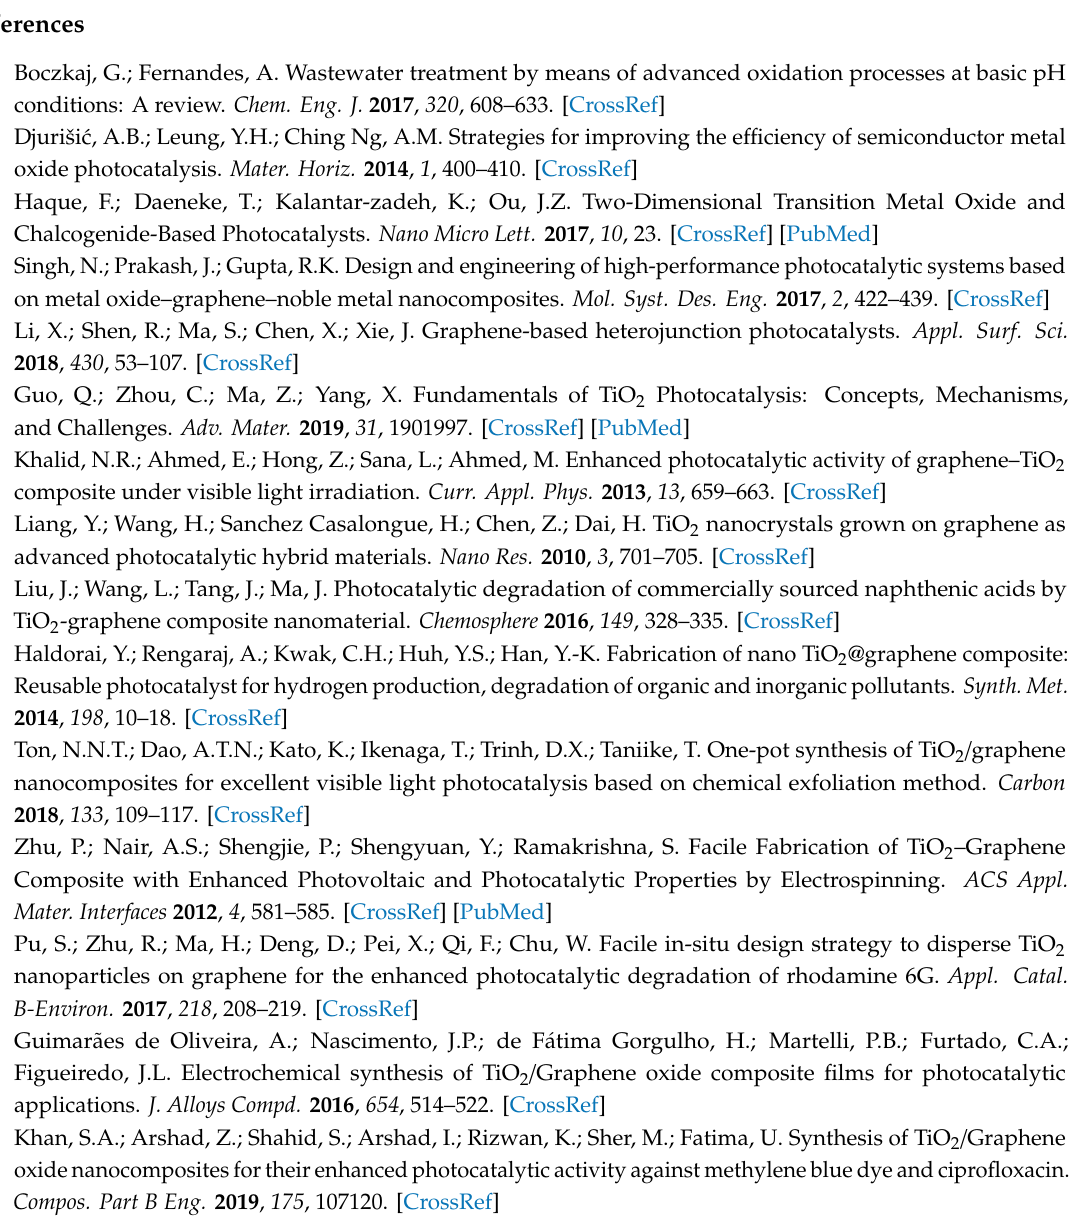
Table S1: The performance of graphene / TiO 2 composite in degradation of organic dyes; Table S2: The performance of graphene / ZnO composite in degradation of organic dyes; Table S3: The performance of graphene / SnO 2 composite in degradation of organic dyes; Table S4: The performance of graphene / WO 3 composite in degradation of organic dyes; Table S5: The performance of graphene / Fe 2 O 3 composite in degradation of organic dyes; Table S6: The performance of graphene / other metal oxides in degradation of organic dyes; Table S7: The performance of graphene-based ternary composite in degradation of organic